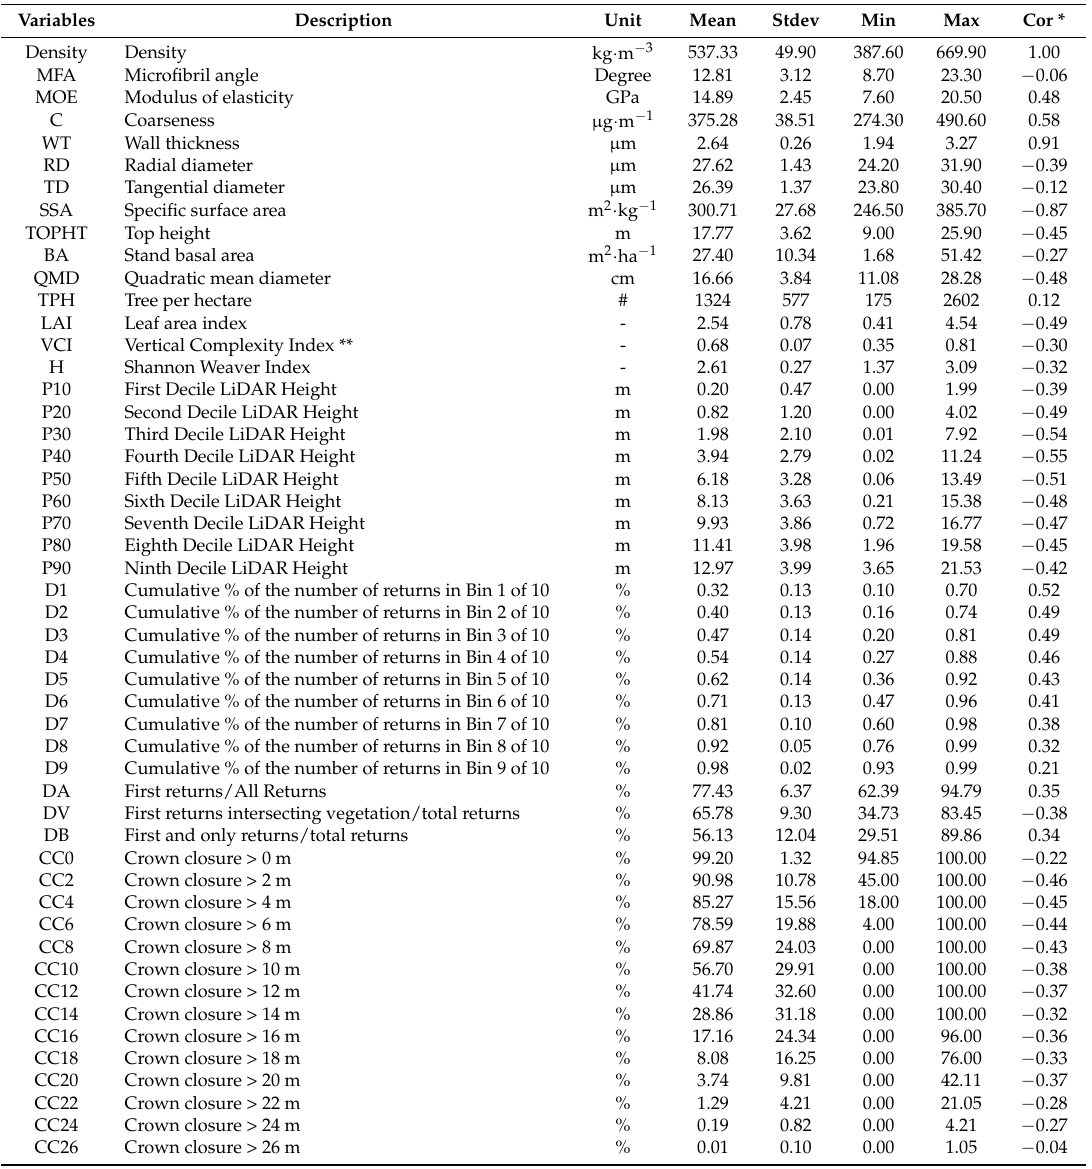
Table 1. Description of selected wood quality attributes and LiDAR derived variables. Correlation was estimated between the variable of interest and wood